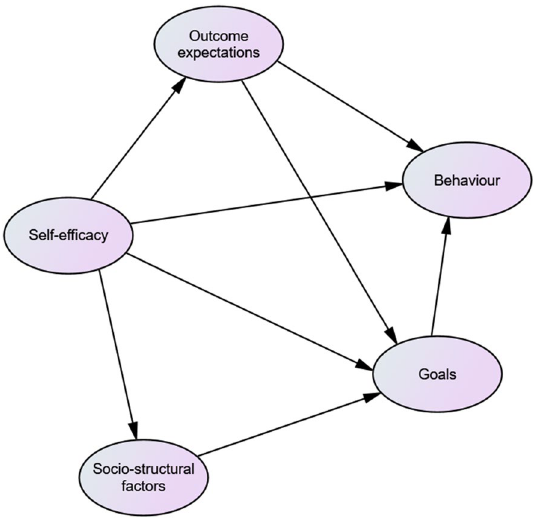
Figure 2. Hypothesized Structural Equation Modeling paths describing farmers’ behaviour towards the administration of antimicrobials in commercial chicken flocks in Chattogram,